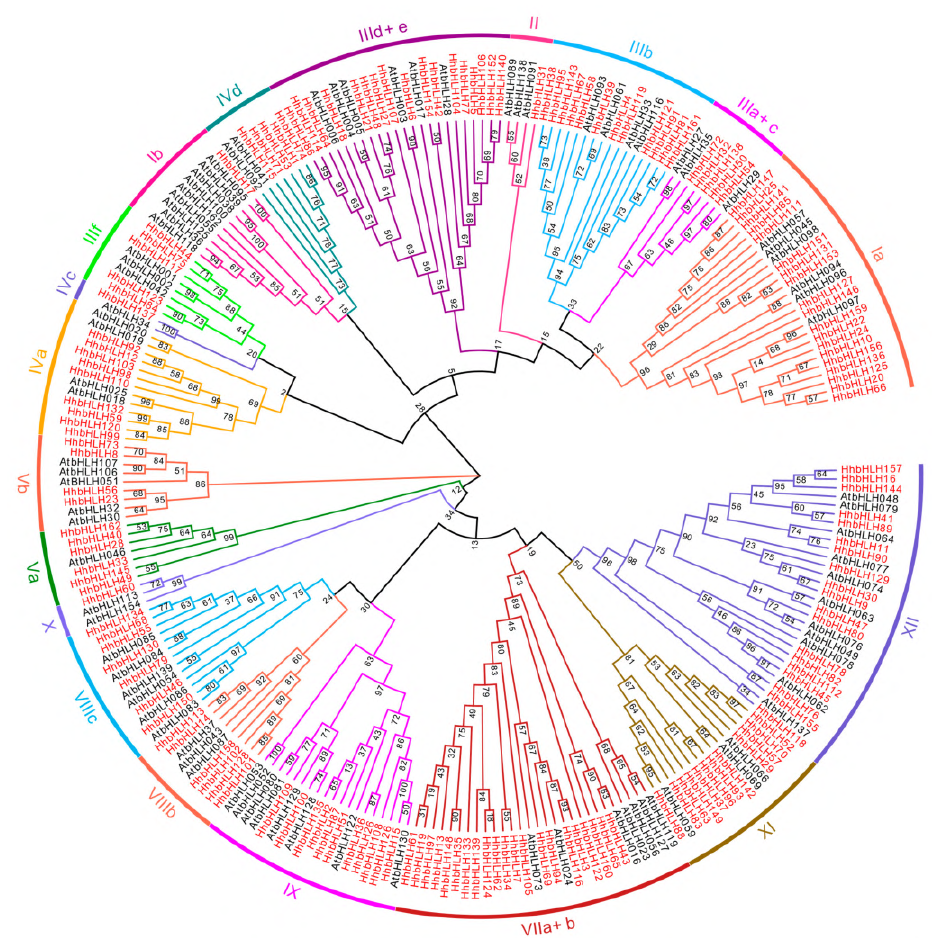
Figure 2. Unrooted phylogenetic tree of bHLH proteins from Arabidopsis thaliana , and H. ham- abo . MEGA7 was used to construct the phylogenic tree from the sequences of the domain protein. Evolview was used to annotate and analyze the phylogenic tree. Various background colors show the HhbHLH protein